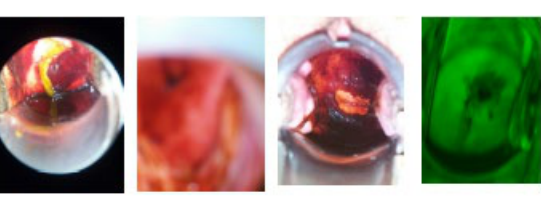
Figure 1. High-Quality cervix images from main dataset